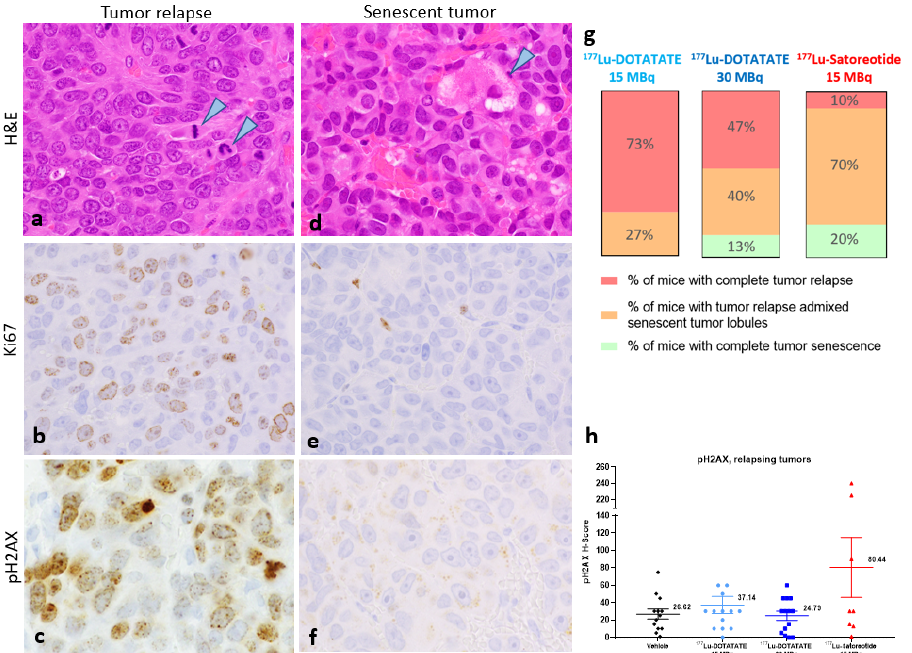
Figure 5. Histopathological and immunohistochemical analyses at the end of the study. Two distinct tumor phenotypes were noted: a re-growing/relapsing phenotype ( a – c ), and a senescent phenotype ( d – f ). In re-growing/relapsing tumours, mitotic figures were commonly seen ( a , arrowheads) and associated with Ki67-positive staining ( b ). pH2AX expression was in some re-growing/relapsing tumours ( c ), which were treated with [ 177 Lu]Lu-satoreotide tetraxetan ( h , H-score > 200). In senescent tumours, there was no presence of mitoses of degenerating cancer ( d , arrowhead) and a lack of Ki67 ( e ) and pH2AX ( f ) staining in cancer cells. All images were taken at the objective 100. ( g ) illustrates the proportion of mice with different tumour phenotypes in each treated group. ( h ) illustrates the mean ± standard error of the mean pH2AX H-score at the end of the study in re-growing/relapsing tumours.